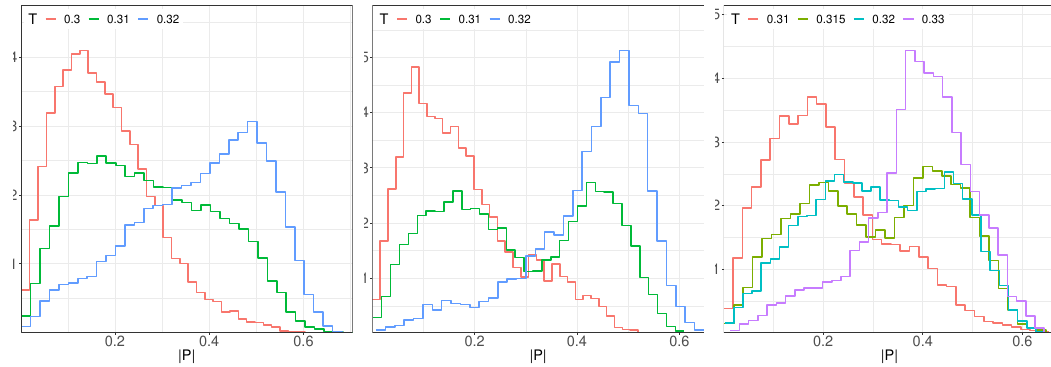
Figure 20. Full BMN model: histogram of P close to the critical temperature for µ = 1 . 0 . From left to right, N = 12 , L = 12 ; N = 16 , L = 12 ; N = 12 , L = 24 . A two-state signal is observed. A consistent signal with lower statistics has also been observed for N = 12 , L = 36 , confirming the trend of the critical temperature to slightly increase in the continuum